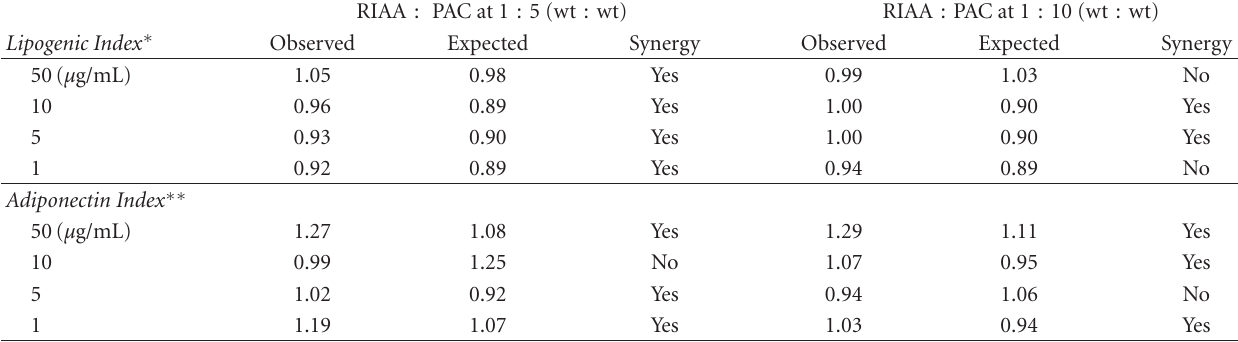
Table 1: Observed and expected lipogenic response elicited by hops RIAA and acacia PAC in the 3T3-L1 model. RIAA : PAC at 1 : 5 (wt :